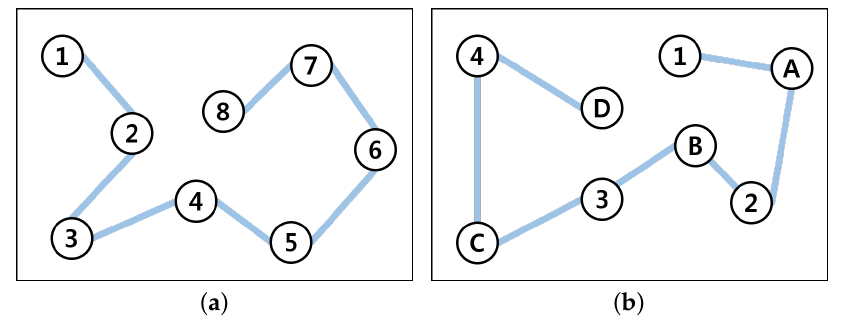
Figure 2. Trail Making Test ( a ) TMT-A ( b )